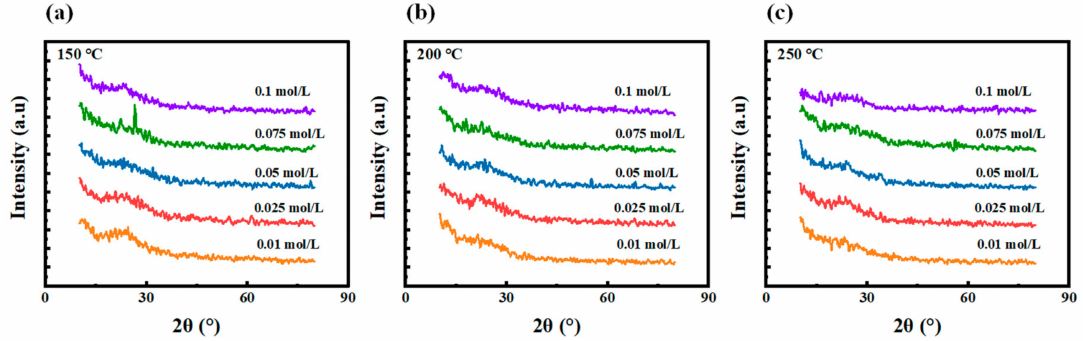
Figure2. X-raydi ff raction(XRD) spectraof Zr–AlO x filmswith di ff erentZrconcentrations: ( a )annealing at 150 ◦ C, ( b ) annealing at 200 ◦ C, and ( c ) annealing at 250 ◦ C. The authors would like to apologize for any inconvenience caused to the readers by these changes.